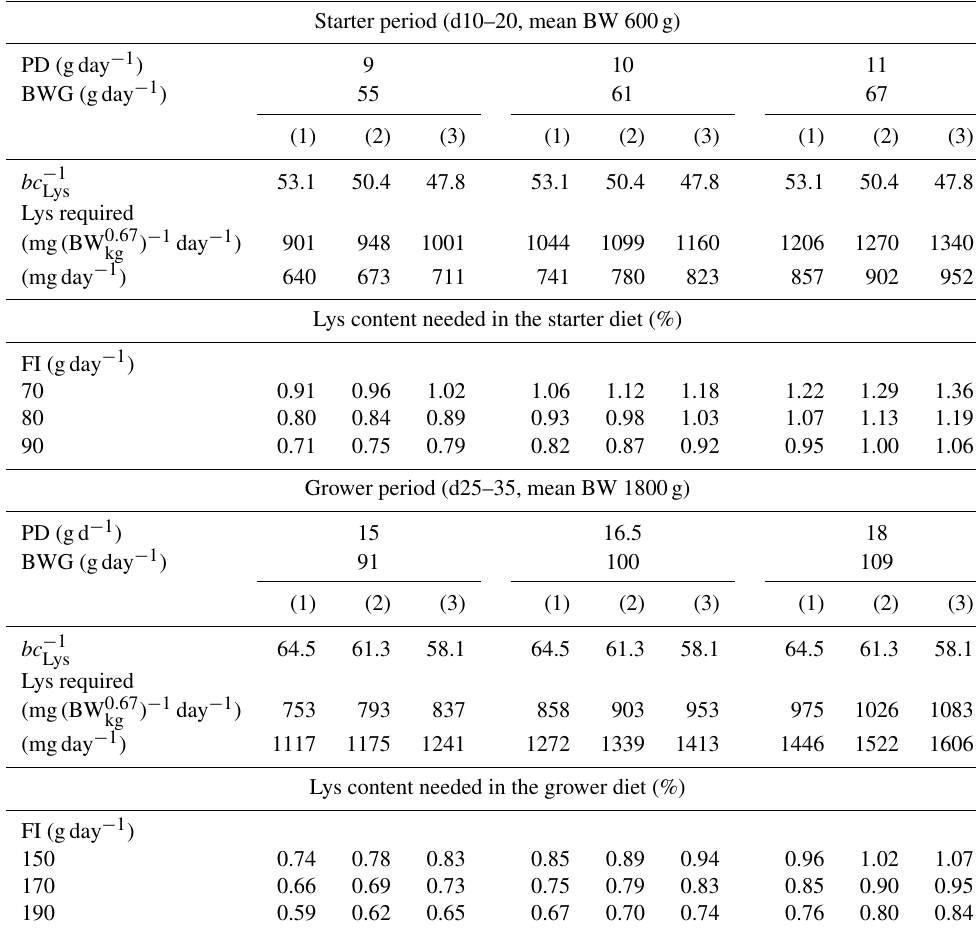
Table 4. Example for modelling lysine (Lys) requirement data during the starter and grower periods of male meat-type chickens (Ross 308) depending on graded daily protein deposition, different in-feed efficiency of Lys, and predicted daily feed intake (Wecke et al.,